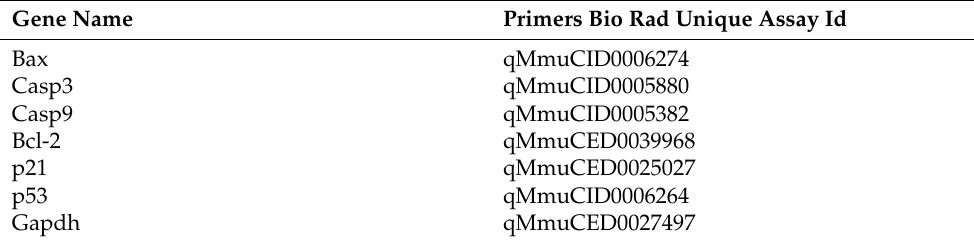
Table 1. Bio-Rad IDs for the qRT-PCR